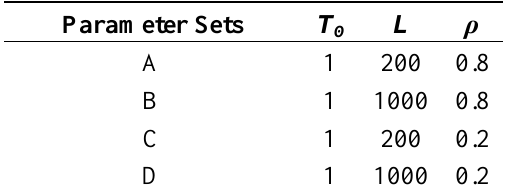
Table 5. Parameter combinations of the SA algorithm.